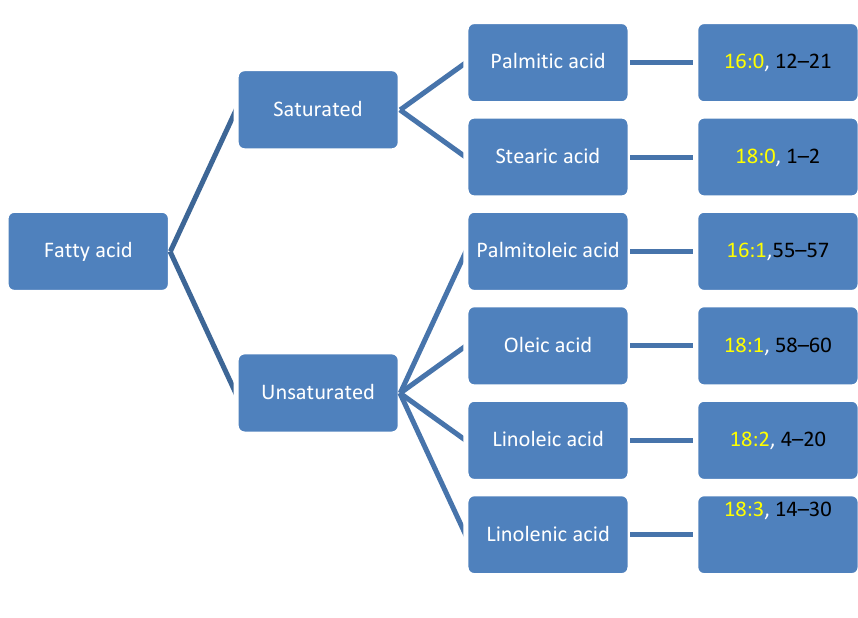
Note: Yellow colors are the chain length; Black colors are the oil constituent (without lipid). Fig. 11. Fatty acid content of algae lipid. [23],